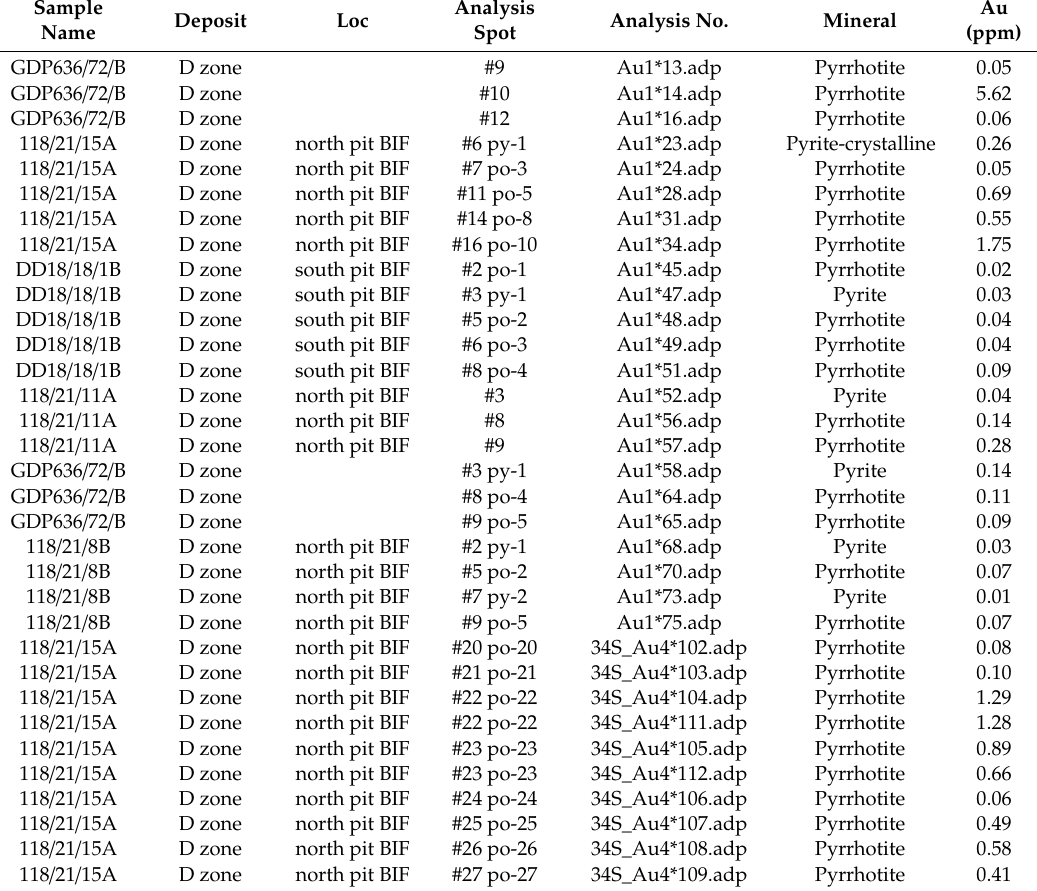
Table A1. Results of the SIMS Au analysis of pyrite and pyrrhotite grains from the Kalahari deposit.